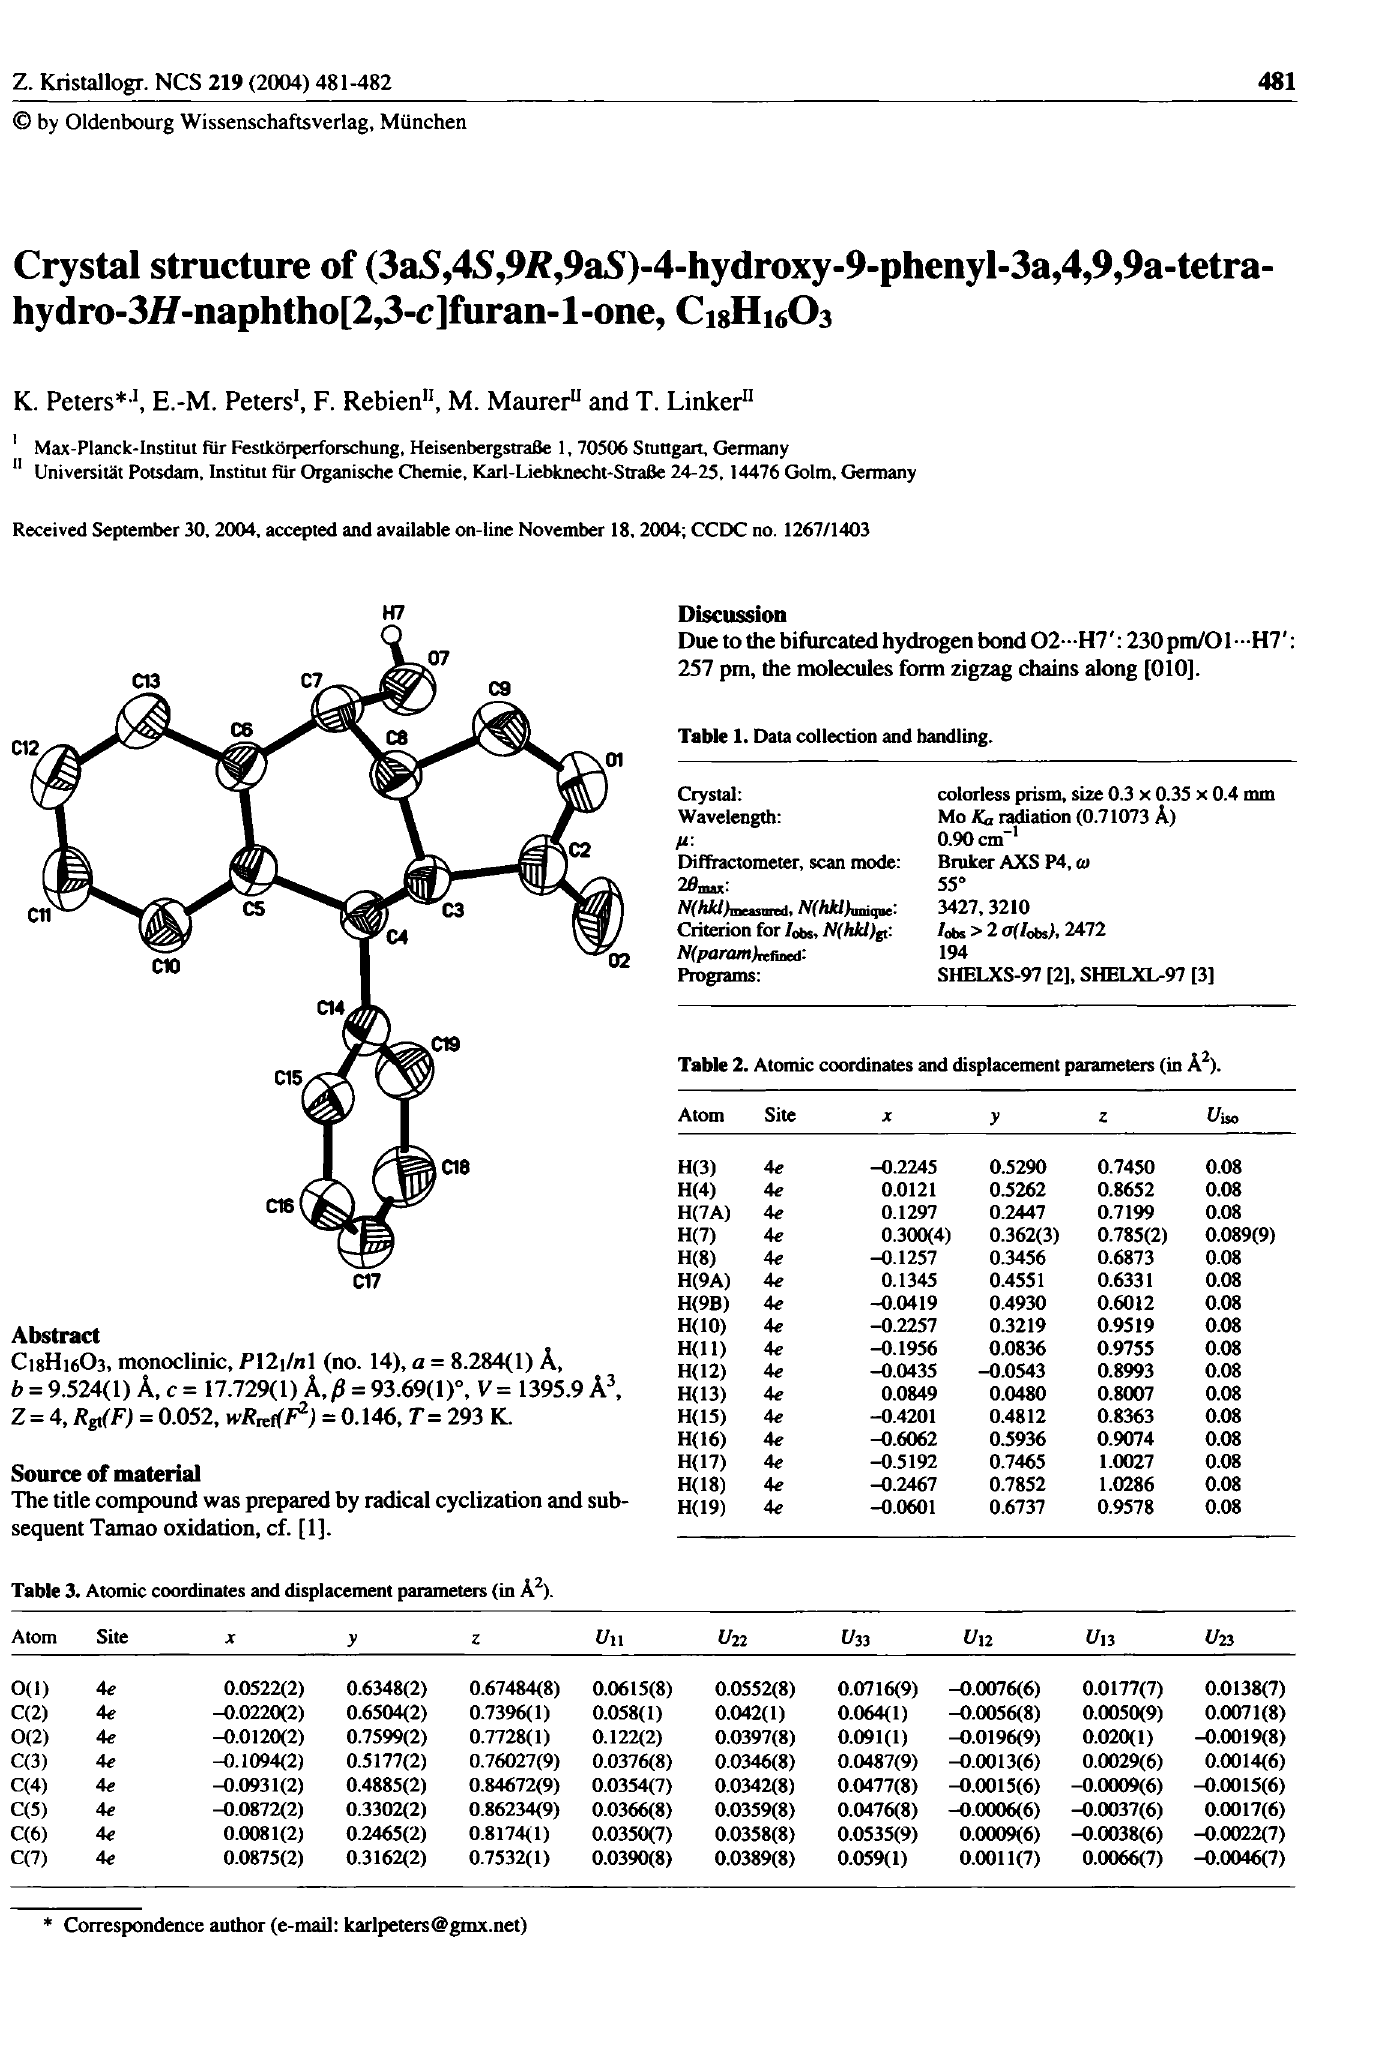
Table 2. Atomic coordinates and displacement parameters (in Ä 2